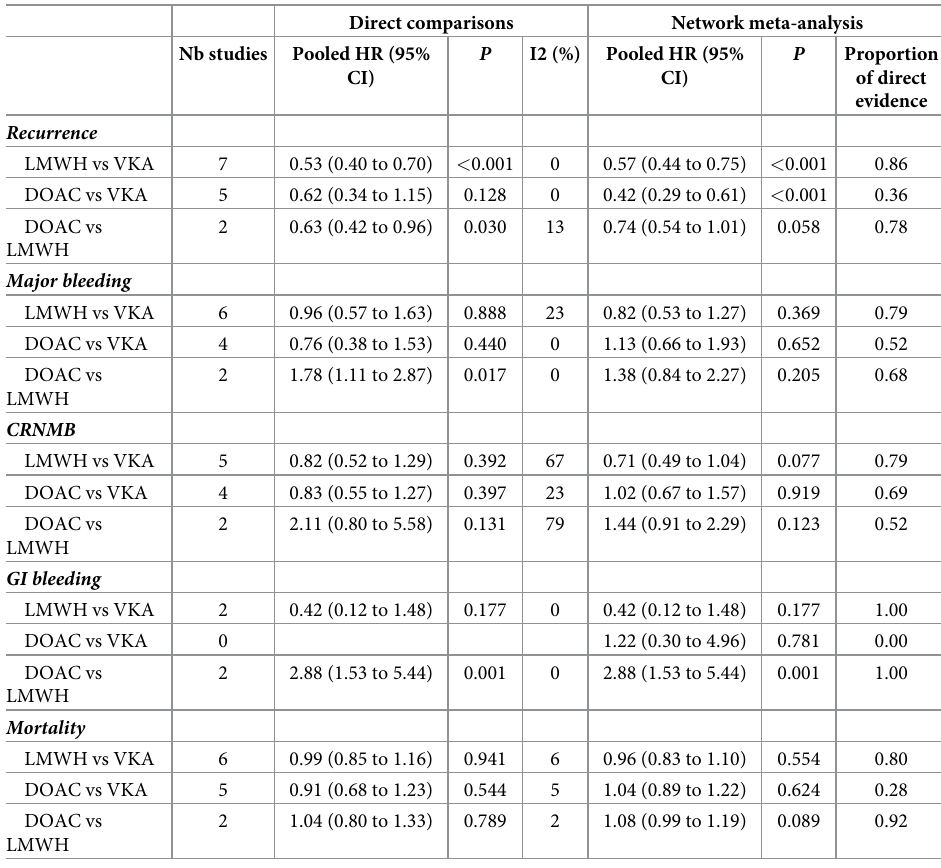
Table 2. Direct and network